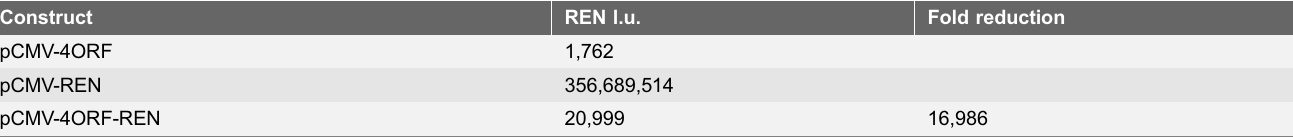
Table 2. Suppression of the activity of the renilla luciferase transgene by the 4ORF